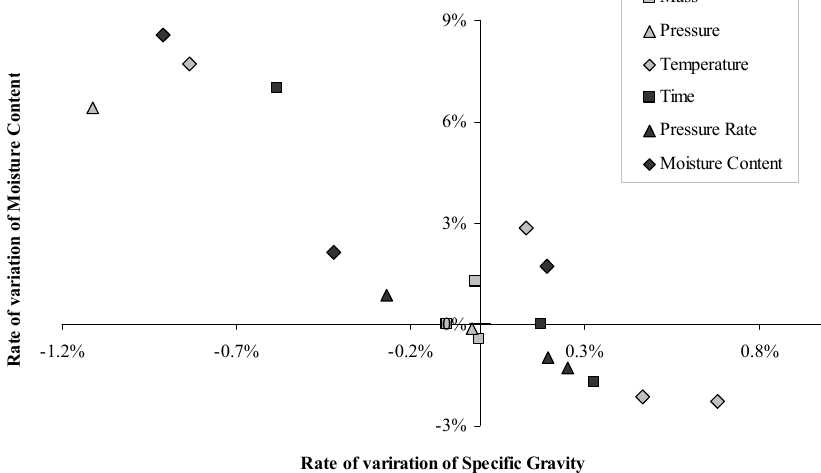
Figure 11. Rate of variation of moisture content versus rate of variation of specific gravity. Rates of variation calculated comparing each modality to the control